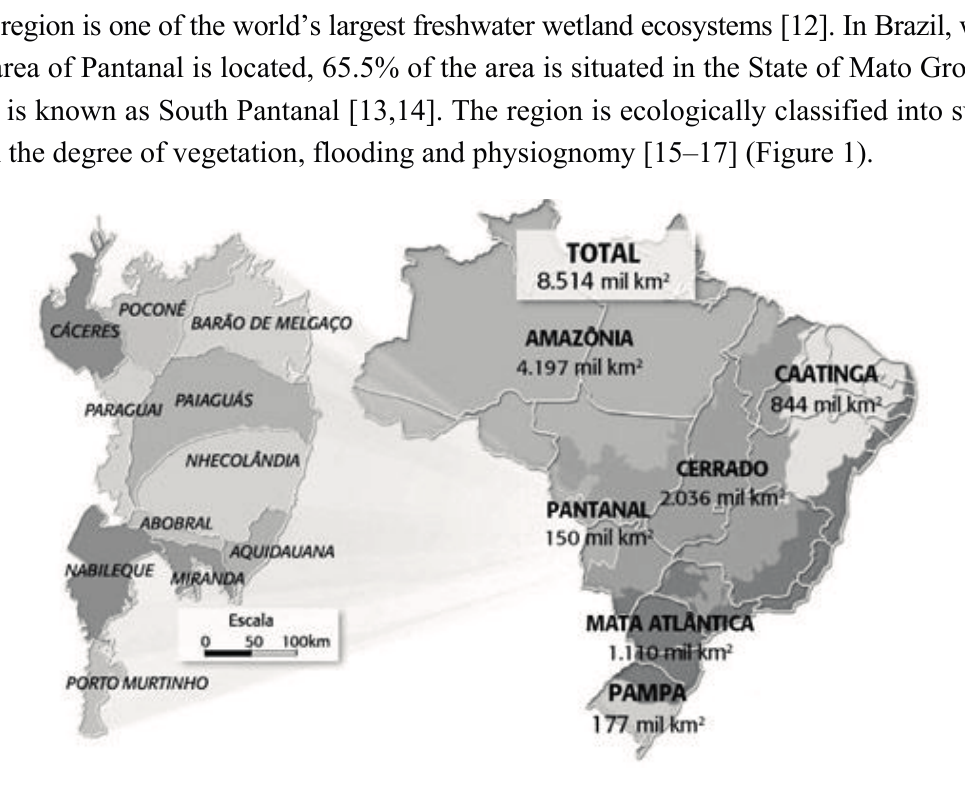
Figure 1. Sub-regions of the Brazilian Pantanal area (adapted from Globo Rural-Edition © 288-October